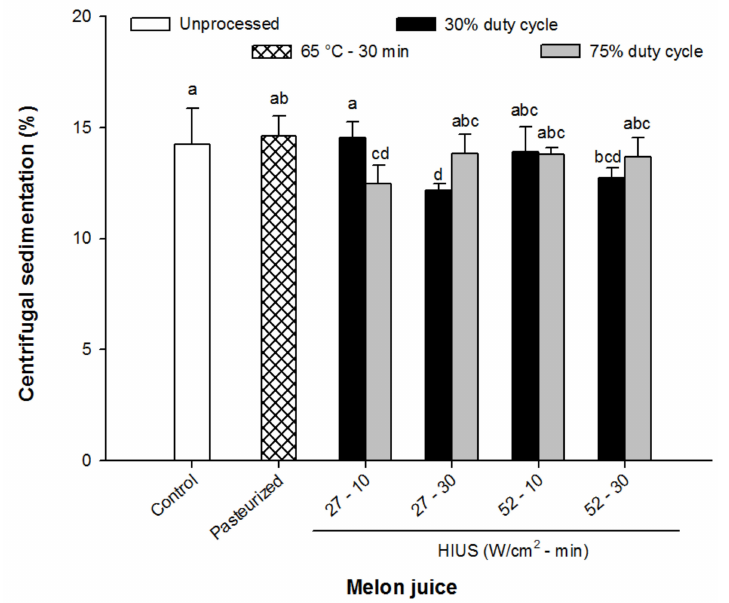
Figure 1. Centrifugal sedimentation of control (unprocessed), pasteurized and HIUS processed melon ( Cucumis melo ) juice. Different letters above the bars indicate statistical difference in treatments ( p < 0.05) ( n =